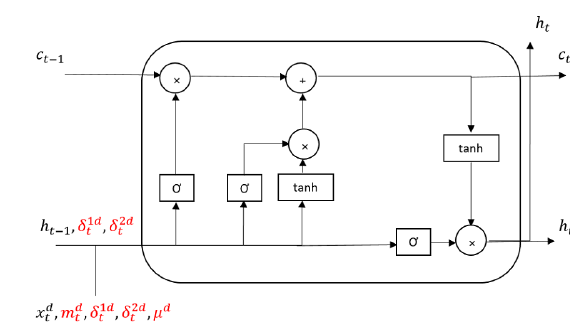
Figure 1. FBVS-LSTM